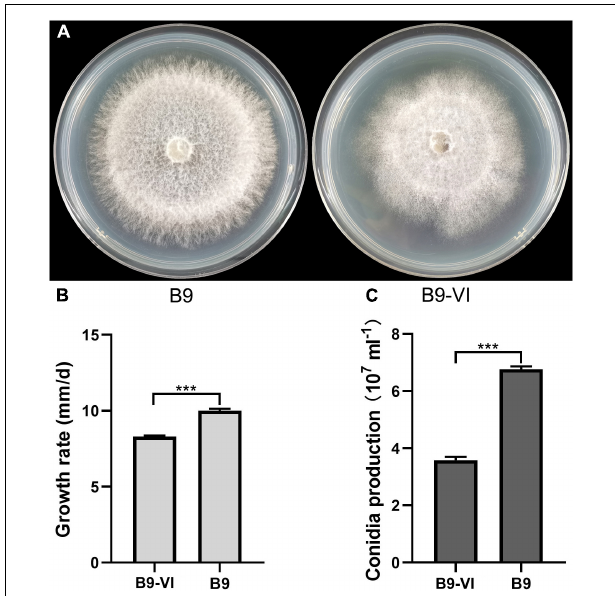
FIGURE 4 | The comparison of different biological characteristic of strain B9 and B9-VI. (A) Culture morphology (25 ◦ C, 10 days) of Fusarium oxysporum strain B9 and B9-VI on PDA medium. (B,C) Comparison of radial mycelial growth rate (B) on PDA (25 ◦ C) and conidia production (C) in CMC (28 ◦ C, 180 rpm) of strain B9-VI and B9, respectively. “***” indicates a significantly different ( p < 0.05) between strain B9 and B9-VI in both radial mycelial growth rate and conidia